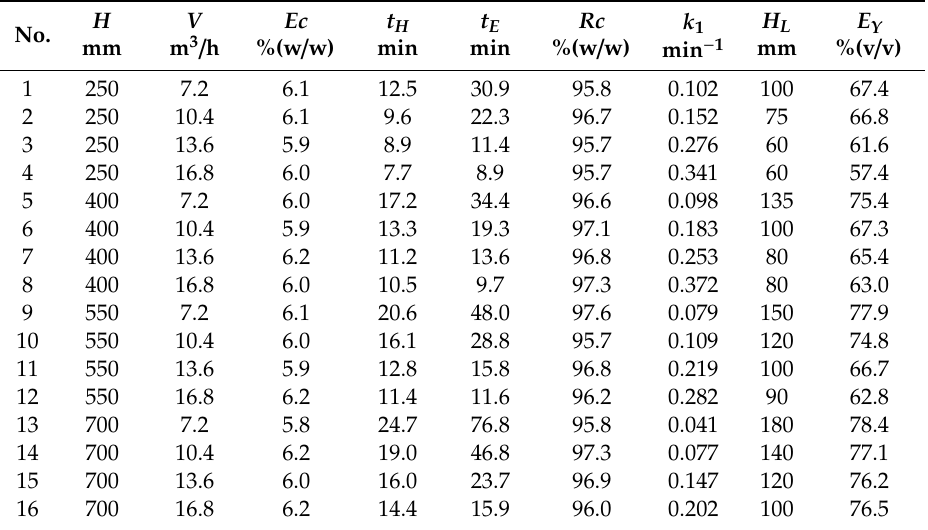
Table 2. Distillation experiments results in di ff erent loading height and steam flow